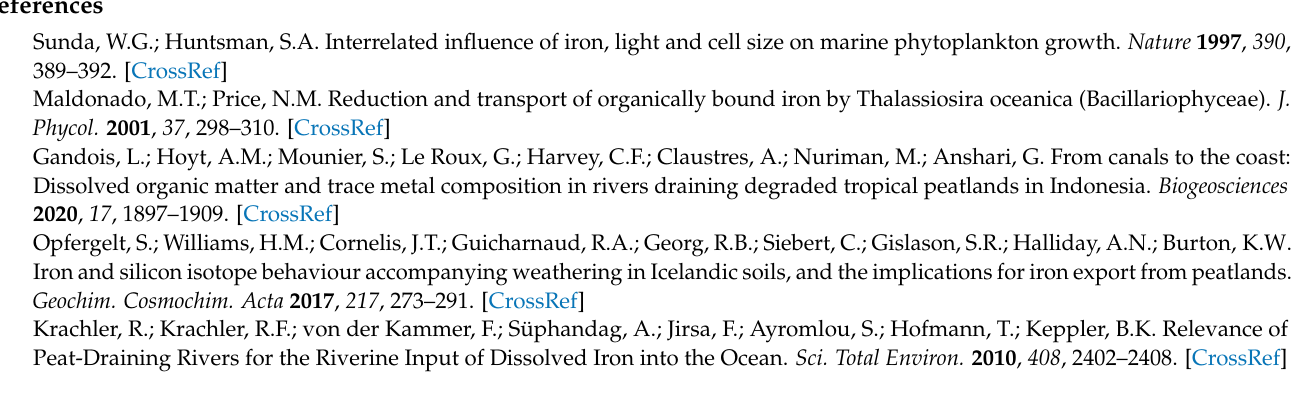
Figure S3: 3D EEM of bulk PPFA with different Fe concentrations; Figure S4: 3D EEM of PPFA with different molecular weight before and after interaction with Fe(III); Figure S5: Modified Stern- Volmer plots for the fluorescence quenching of PPFA by Fe(III) on peak A and peak C; Table S1: Table S2: The percentage content of all grades of PPFA; Table S3: The concentration of experimental substances in the interaction between bulk and fractionated PPFA and Fe; Table S4: Locations and intensities of peaks in EEM spectra of PPFA with different Fe concentrations; Table S5: Locations and intensities of peaks in EEM spectra of PPFA with different molecular weights; Table S6: Measured and corrected Fe concentrations at the acceptor side for different Sr concentrations at the acceptor side and a constant Sr concentration at the donor side using DMT results after 96